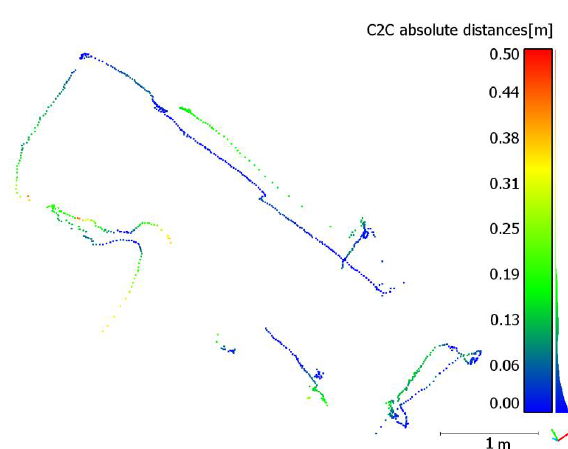
Figure 7 . Slanted view of the Crazyflie 2D point cloud map with trajectory, ceiling and floor points and some height measurements for the ITC dataset